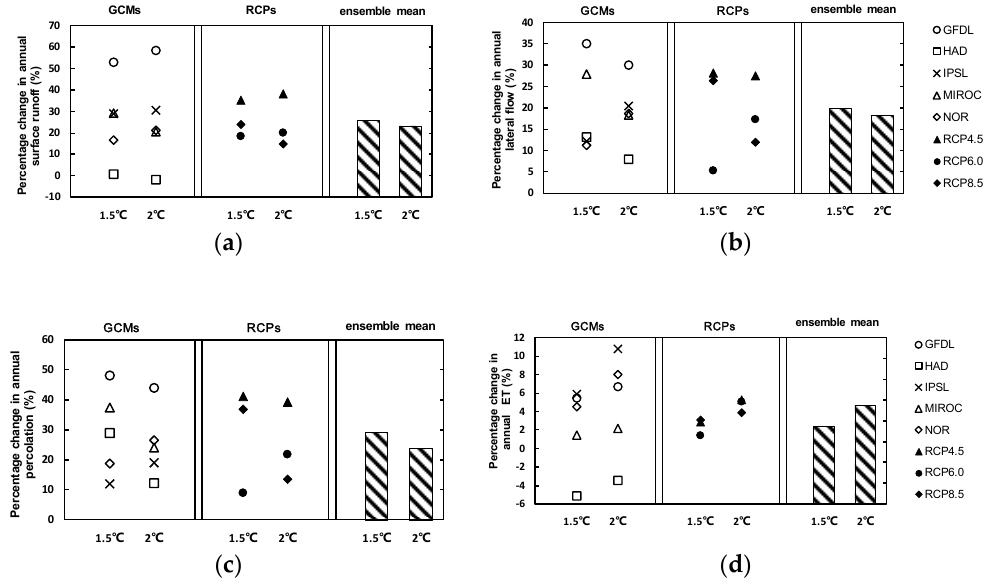
Figure 7. Percentage change in annual surface runoff ( a ), annual lateral flow ( b ), annual percolation ( c ), and annual ET ( d ) under 1.5 °C and 2 °C global warming in CRB.